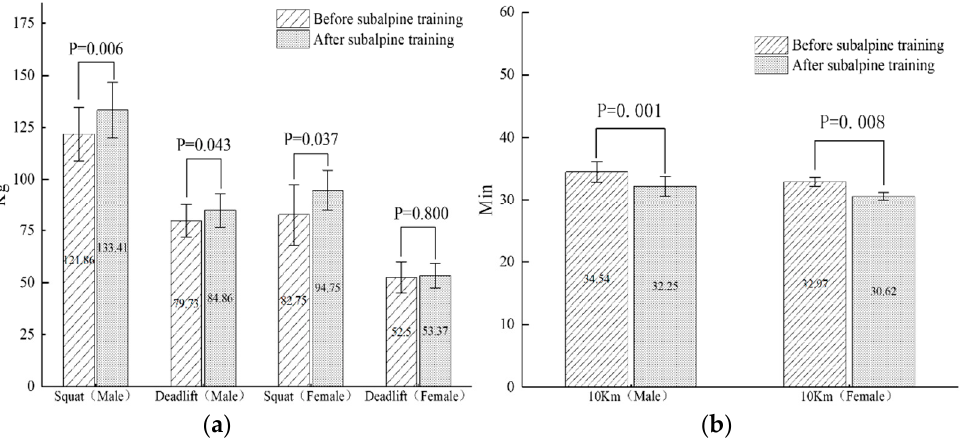
Figure 6. Before and after training values for ( a ) deep squat and bench press; ( b ) 10 km run. Table 9. Changes in athletes’ physical and athletic performance indicators before and after subalpine